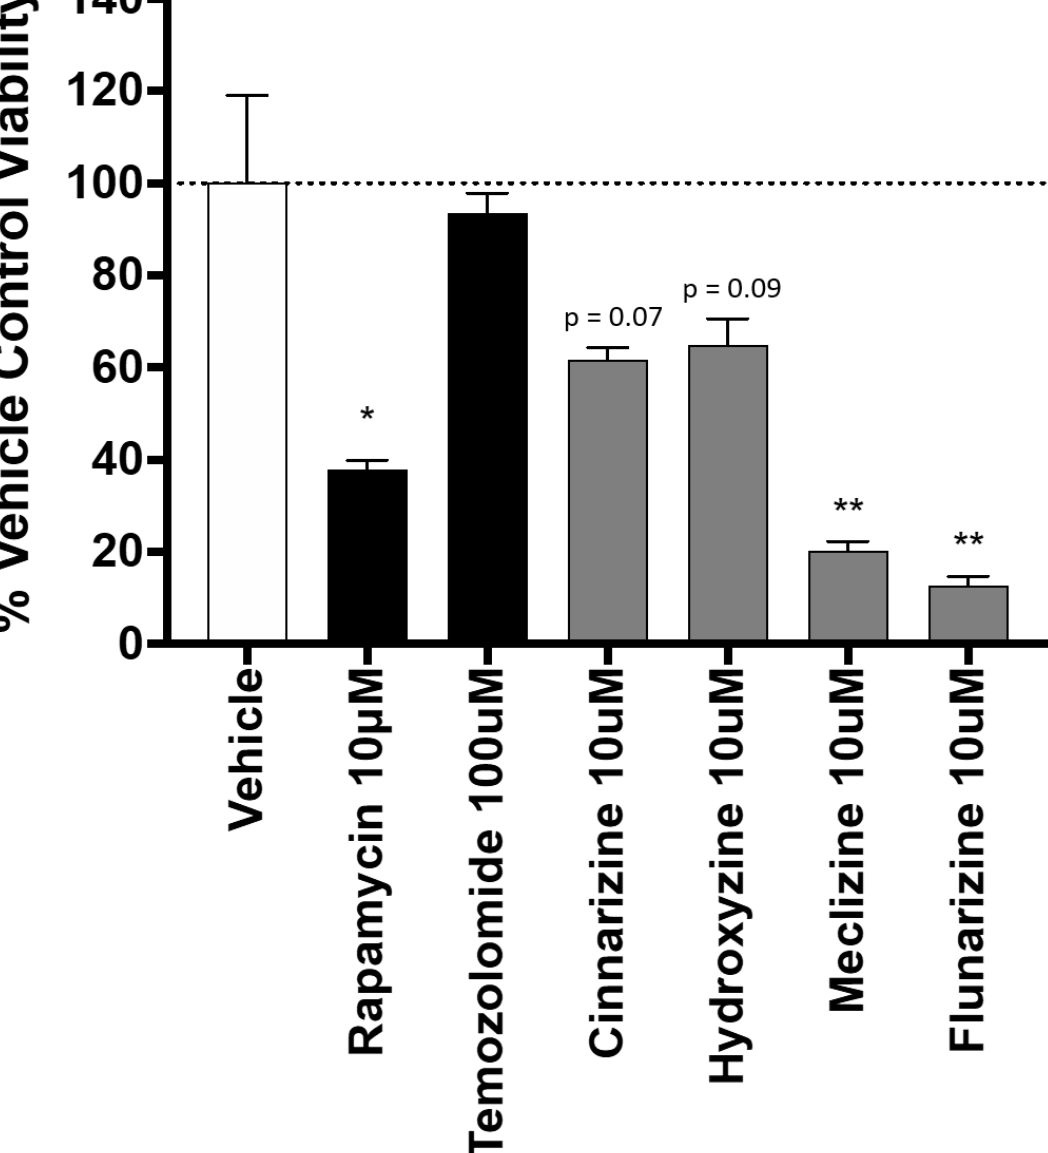
Figure 3. Piperazine drugs reduce viability in the patient-derived GBMSC line. Experiments were completed used Trypan Blue Exclusion. The columns are the average percent viability of three biological replicates normalized to the vehicle control. Error bars are the standard error of the mean. *, **: p < 0.05, p < 0.001, respectively. Compound names and concentrations are indicated. p -values calculated using the two-tailed Student’s t -test. n = 3 for compounds tested. As stated above, p values for cinnarizine and hydroxyzine were 0.07 and 0.09, respectively. p values for meclizine and flunarizine were 0.0082 and 0.0057, respectively.